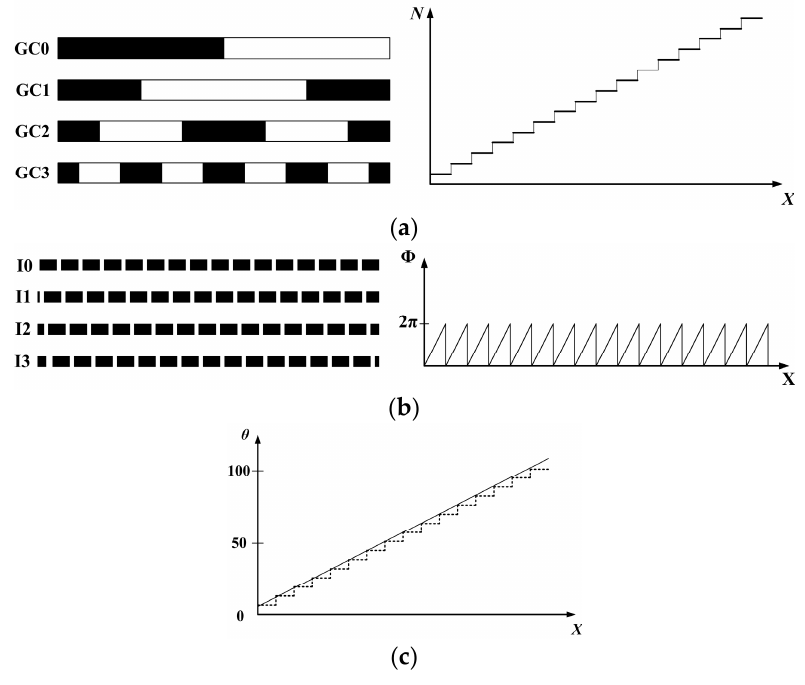
Figure 3. Patterns encoding methods: ( a ) Four-bit gray-code; ( b ) Four-step phase-shifting; and, ( c ) absolute phase by combining four-bit gray-code and four-step phase-shifting.